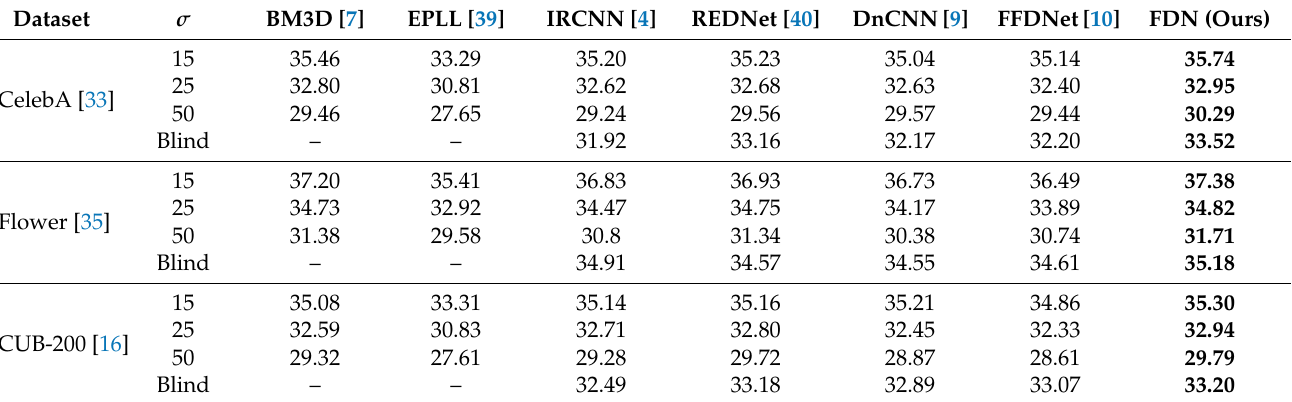
Table 1. Quantitative comparison of removing synthetic noise on three category-specific datasets. Our FDN outperforms the other competitive methods on all of the three datasets for various noise levels.